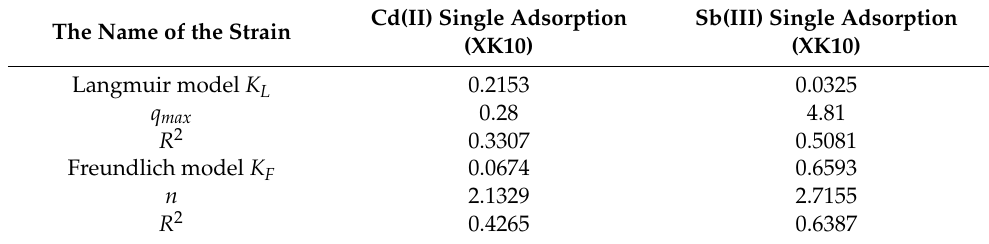
Table 1. Parameters of isotherm model on biosorption of Cd(II) and Sb(III) by XK10. The Name of the